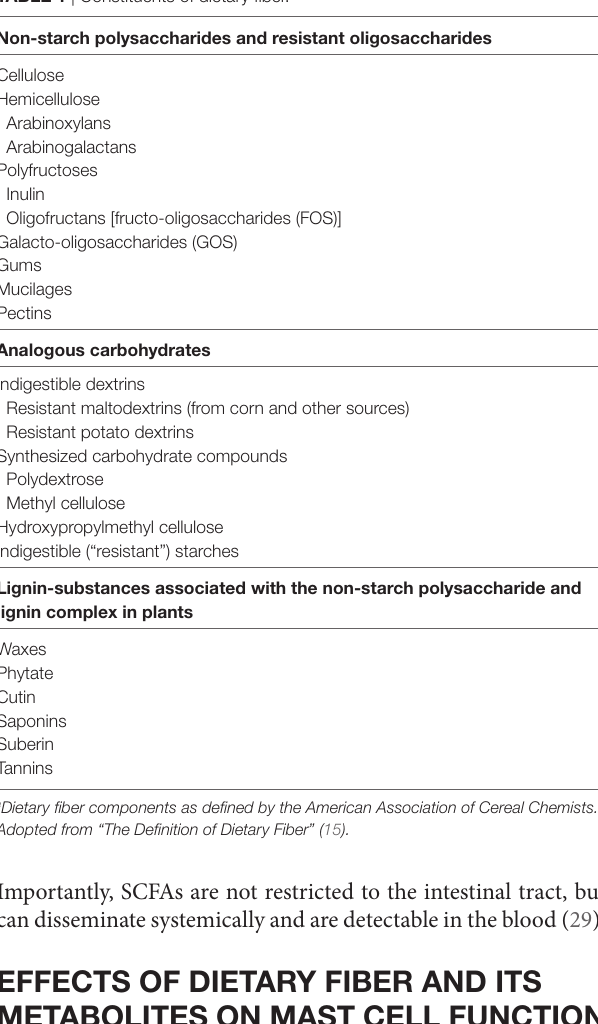
TAble 1 | Constituents of dietary fiber.